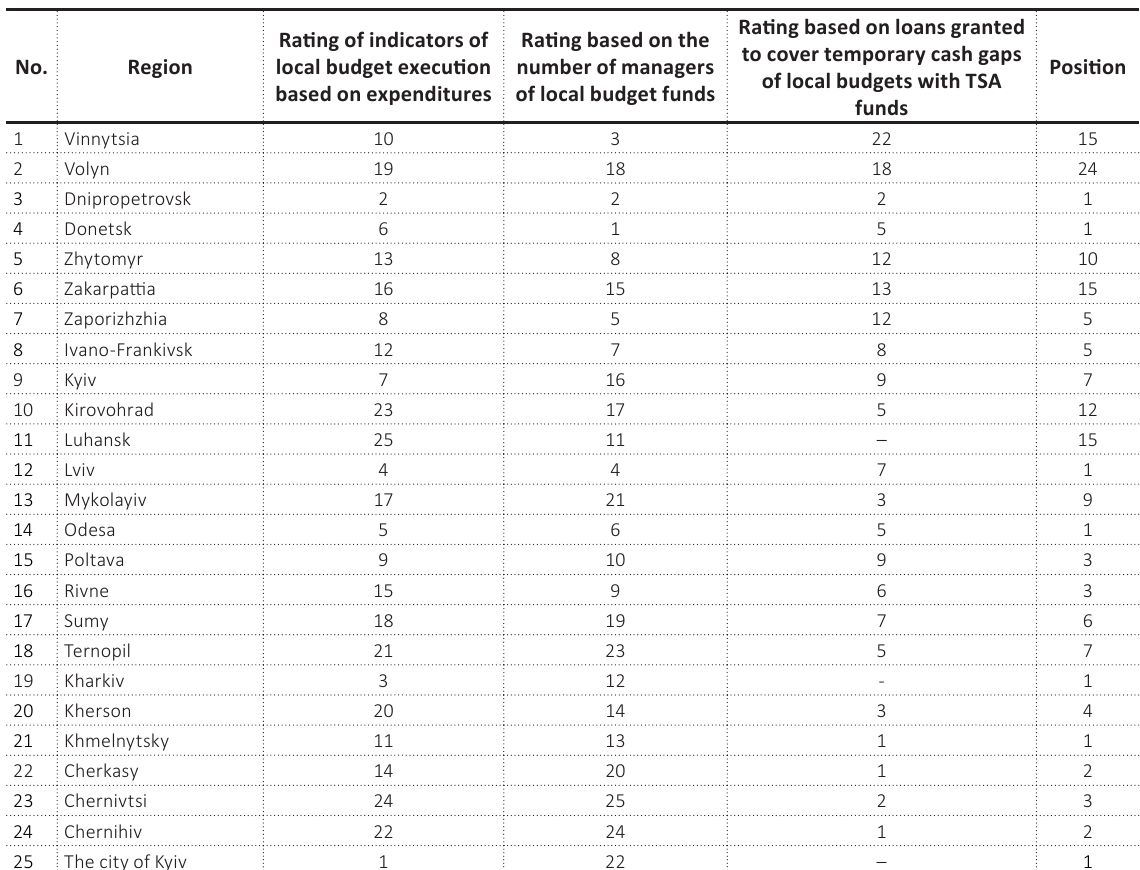
Table 2. Rating of administrative-territorial units of Ukraine in 2021 by individual indicators